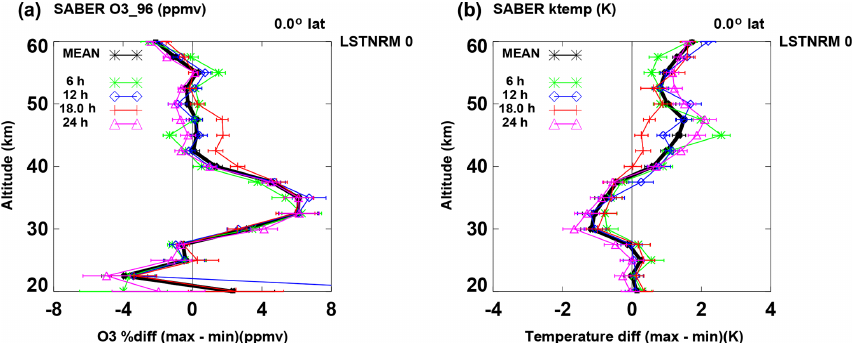
Figure 7. As in Fig. 6, but from 20 to 60km. Ozone (a) and temperature (b) responses at 0 ◦ . Values are responses at solar max minus responses at solar min for ozone (%/100sfu) and for temperature (K/100sfu). Black asterisks denote our responses based on zonal means that are averages over both longitude and local time; green asterisks denote our responses of zonal means at 6LST, blue diamonds represent responses of zonal means at 12LST, red plusses represent responses of zonal means at 18LST, and magenta triangles represent responses of zonal means at 24LST, based on SABER